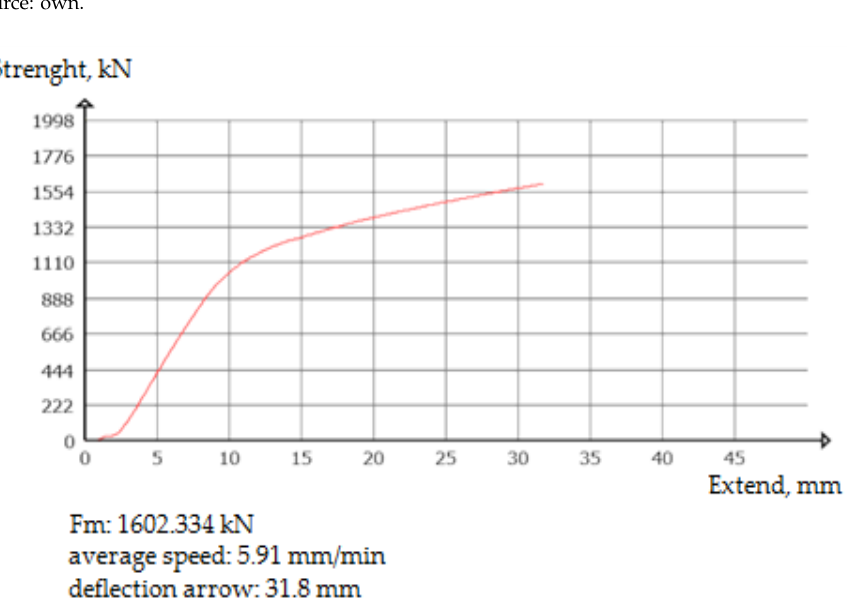
Figure 17. Bending diagram of a welded rail joint. Source: own.